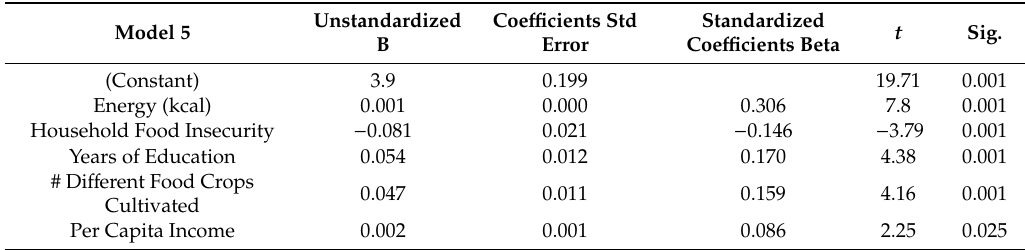
Table 3. Multiple regression analyses identifying the contributions of each of the 5 variables in Model 5 that contribute significantly to explaining the variance in the dietary diversity scores of the women from small holder